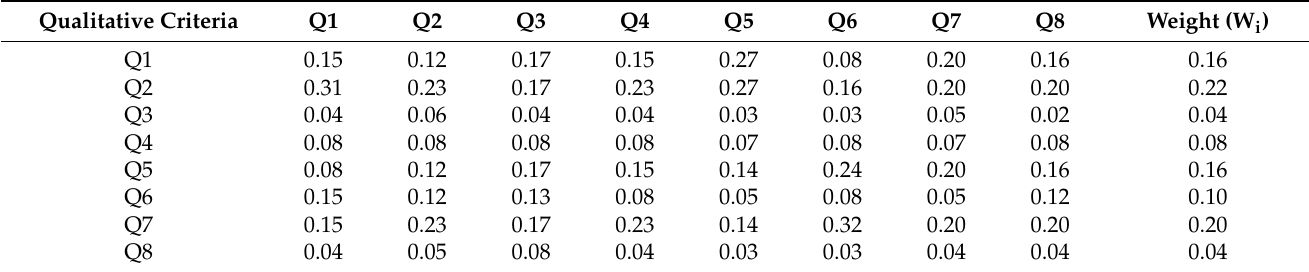
Table 8. Weights of qualitative criteria of PV. Own study.